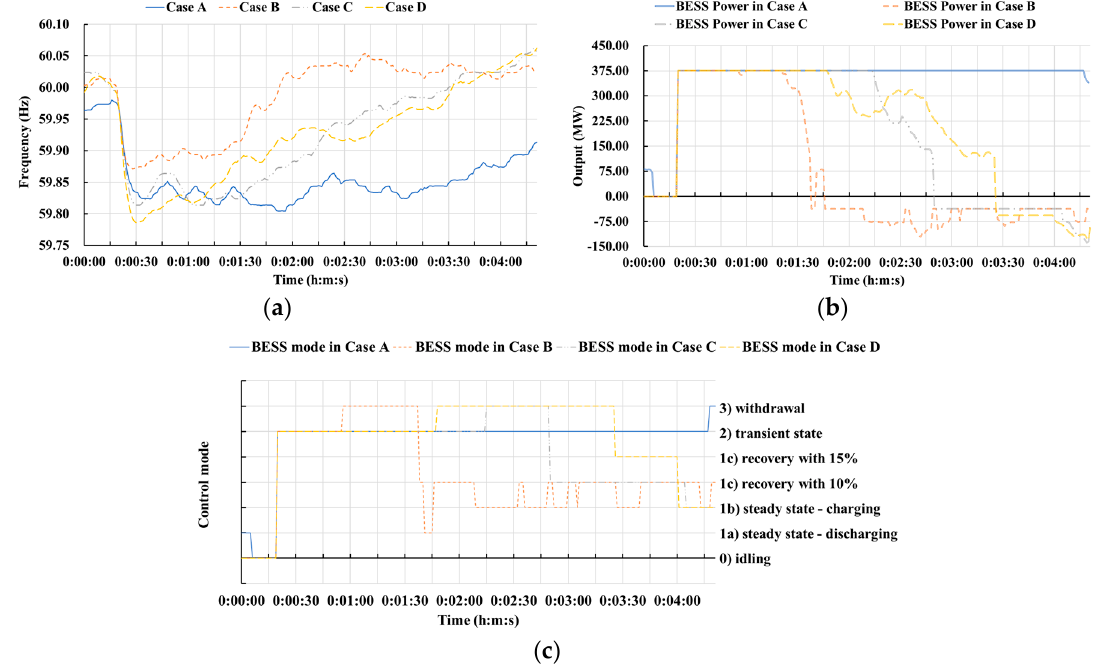
Figure 7. Simulation verification of the proposed control strategy: ( a ) measured frequency data; ( b ) control output of BESS; and ( c ) control mode of BESS.